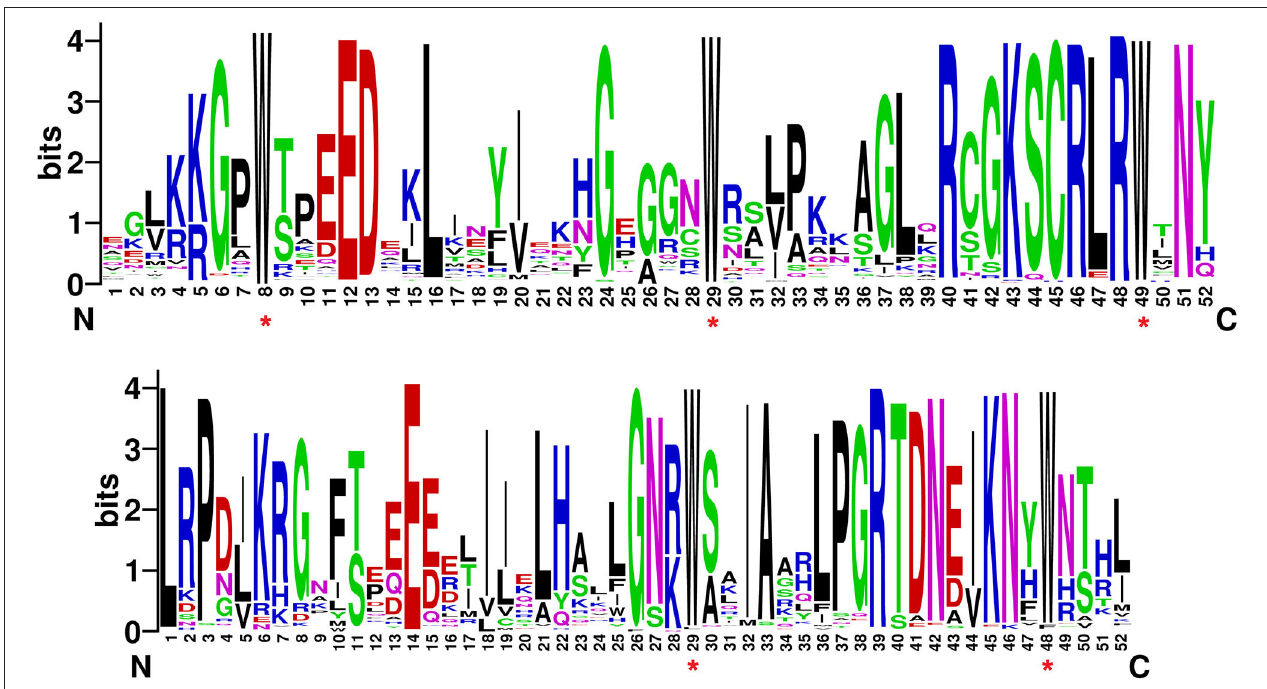
FIGURE 3 | Sequence logo of (A) R2 and (B) R3 MYB repeats in C. chinense